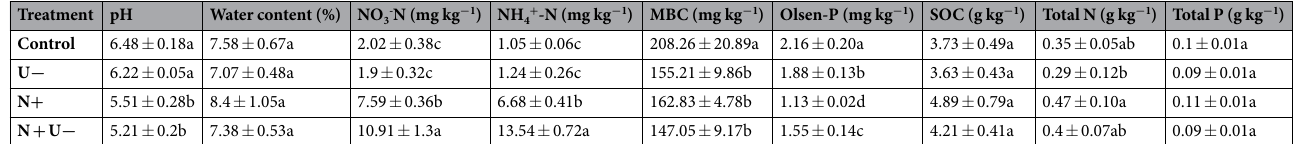
control plots (the control without any disturbance, Table 1), respectively. Soil NO 3 -N and NH 4 + -N concentrations were significantly affected by N addition and its interaction with understory removal, but not by understory removal alone (Supplementary Table 1). Soils in the N + and N + U − plots had 2.8 and 4.4 times higher NO 3 -N and 5.4 and 11.9 times higher NH 4 + -N concentration than soils in the control plots (Table 1), respectively. N addition and understory removal both significantly reduced microbial biomass C (MBC) concentration, by an average of 26% relative to the control (Table 1 and Supplementary Table 1). There were no significant effects of any treatment on soil water content and concentrations of total P and soil organic C (SOC). Pearson’s correlation analysis showed that soil NO 3 -N and NH 4 + -N concentrations were correlated nega- tively with Olsen-P ( r = − 0.61, p = 0.013, and r = − 0.56, p = 0.023) and pH ( r = − 0.67, p = 0.005, and r = − 0.80, p = 0.000), but not with other soil variables. Soil Olsen-P and MBC were correlated positively with pH ( r = 0.67,